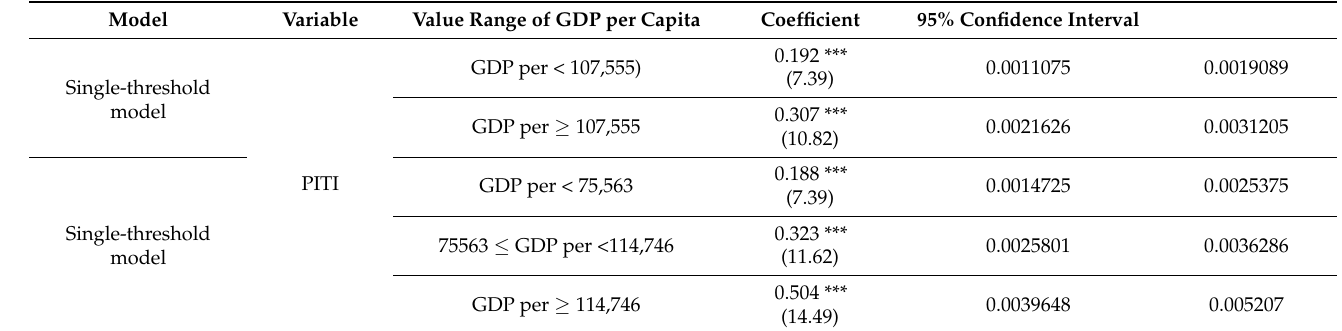
Table 8. Regression results of panel threshold